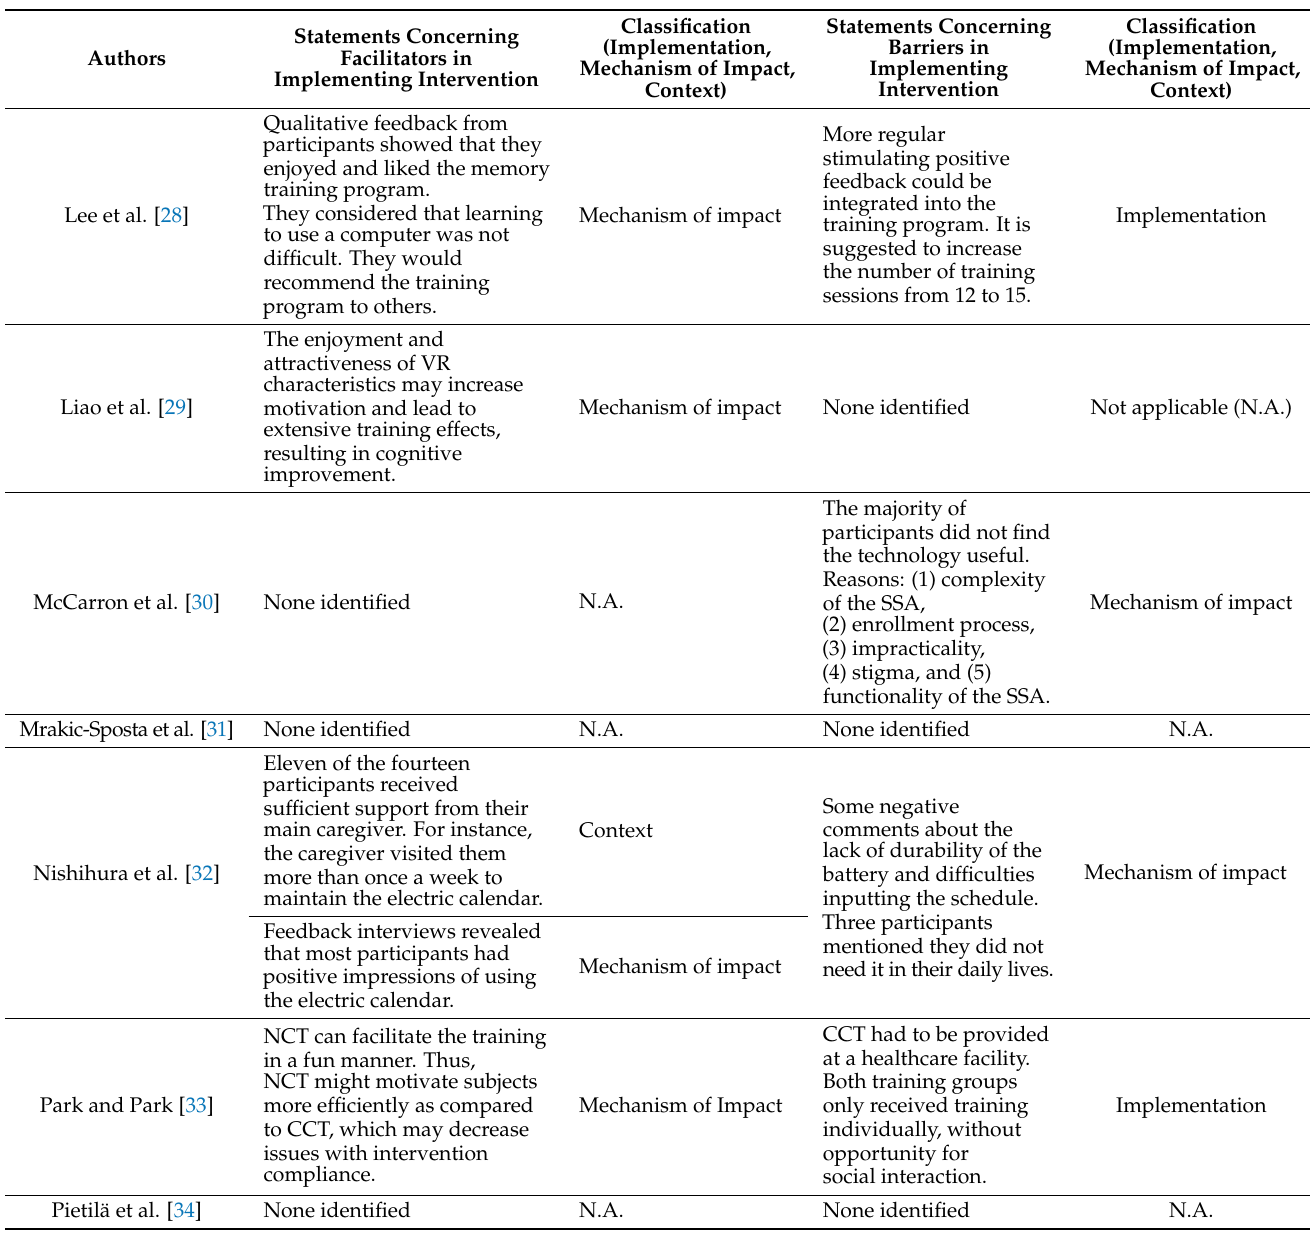
Table 4. Extracted statements from included studies regarding facilitators and barriers to implementation of the technological